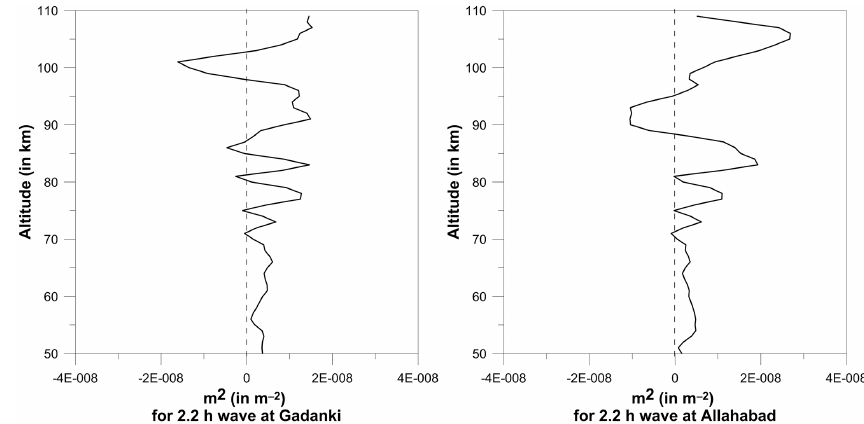
Figure 10. Altitude variation of the squared vertical wave number (m 2 ) for 2.2h wave at Gadanki (left panel) and Allahabad (right panel).